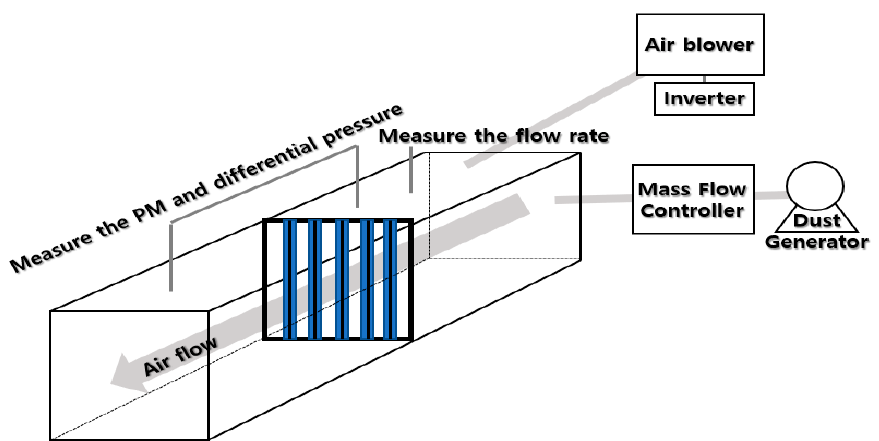
Figure 1. Activated carbon fiber (ACF) system used to evaluate fine particulate matter (PM) filtration performance in this study.